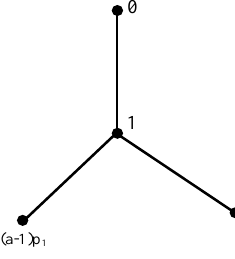
Figure 5. A forbidden subgraph for a line graph in G n .